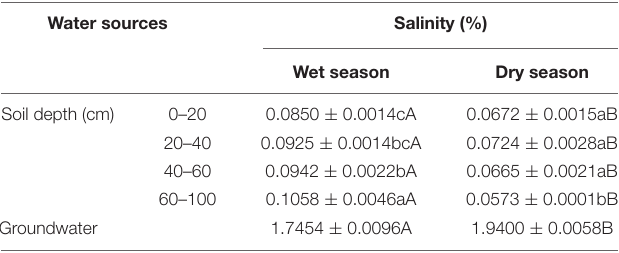
TABLE 1 | Salinity of soil and groundwater in dry and wet seasons (average ± standard